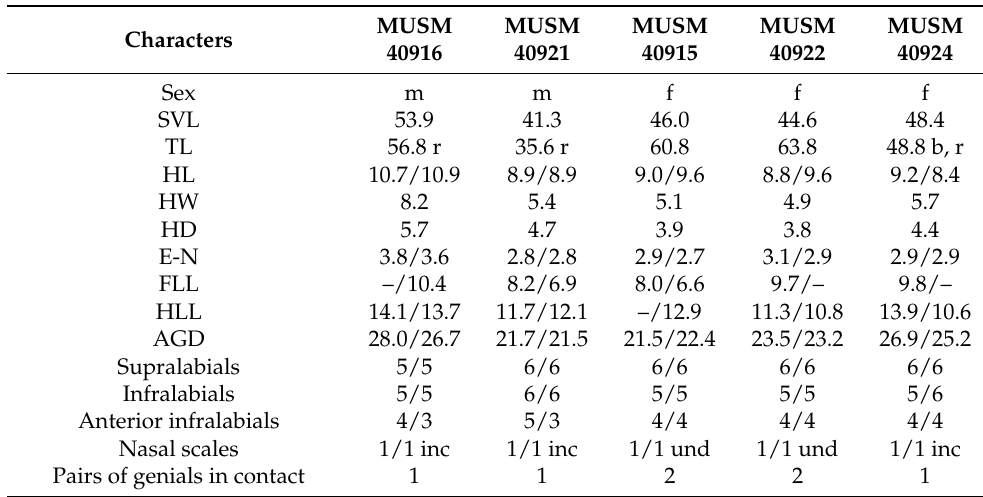
Table A2. Measurements (in mm) and pholidotic characters of adult type specimens of Proctoporus titans sp. nov. A plus sign indicates the presence of a character, a dash indicates its absence, and a diagonal bar separates counts from the left and right body side. TL condition: b = broken, i = incomplete, reg = regenerated. For other abbreviations see materials and